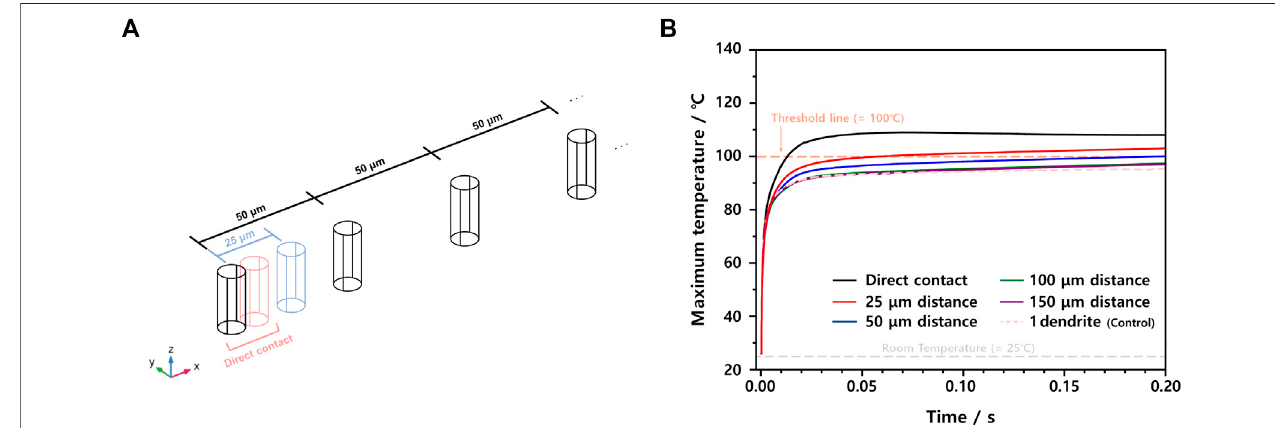
FIGURE4| (A) Scheme describing therelativedistance oftwoLidendritesof5 μ m radius and (B) maximum temperaturepro fi les ofISC models depending on the distance of 10 μ m (direct contact), 25, 50, 100, and 150 μ m.